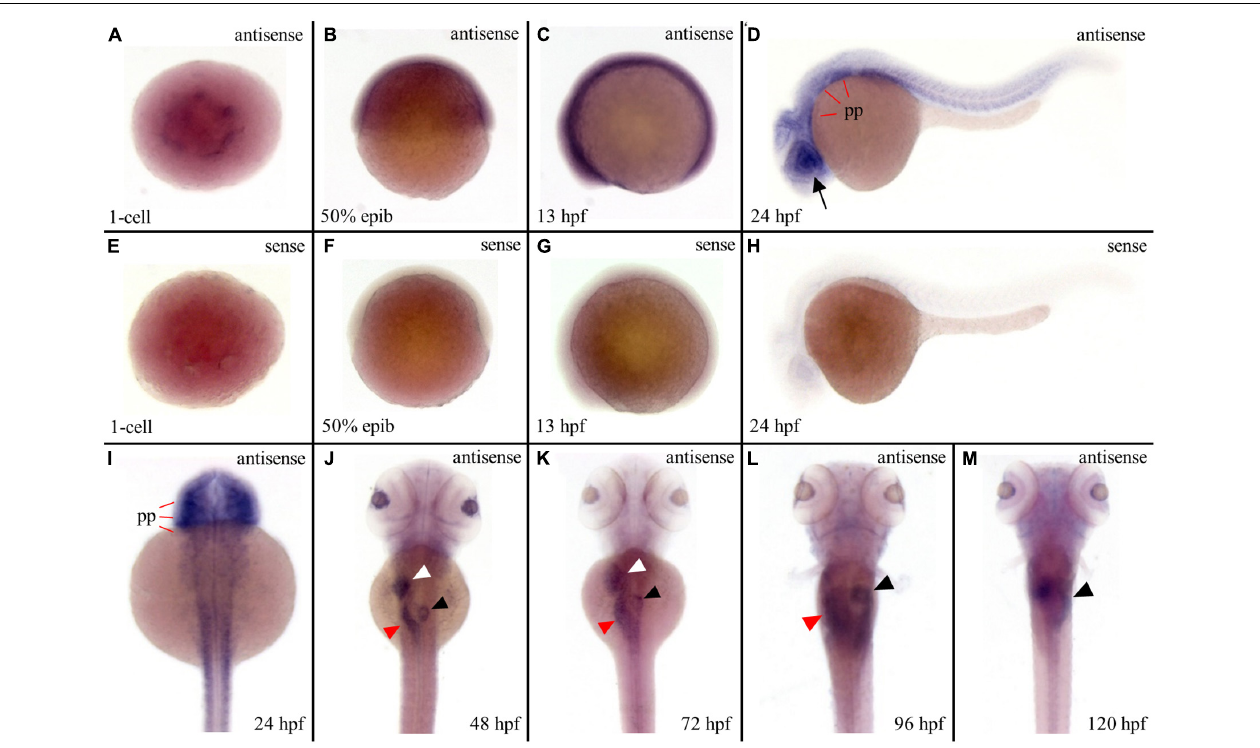
FIGURE 5 | Strong expression of ltv1 in digestive organs. (A,I–M) Dorsal views. (B–D) Lateral views, anterior to the left. (A–D,I–M) WISH using ltv1 antisense probe in wild-type embryos at the stages as indicated in each panel. (E–H) As a negative control, ltv1 sense probe is used to perform the WISH. Black arrow: eye. White arrowhead: liver. Red arrowhead: intestine. Black arrowhead: exocrine pancreas. pp: pharyngeal